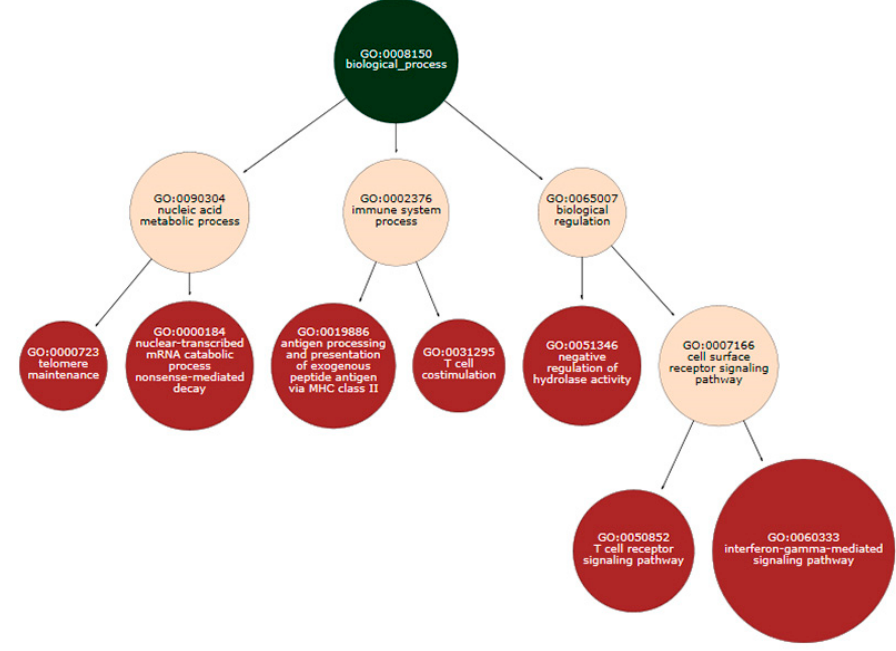
Figure 3. GSE42861: differentially methylated genes mapped onto Gene Ontology using BioInfoMiner.